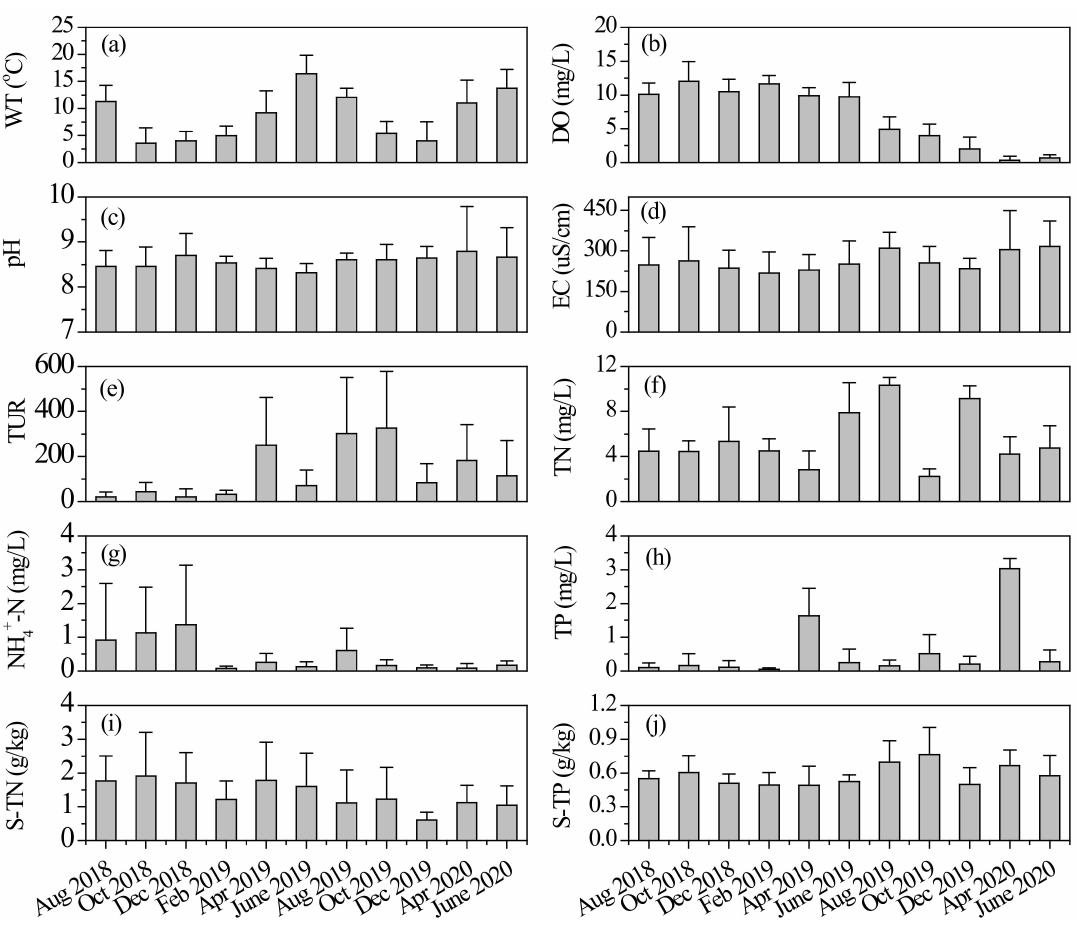
Figure 2. Average values of ( a ) water temperature, ( b ) dissolved oxygen, ( c ) pH, ( d ) electrical conductivity, ( e ) turbidity, ( f ) total nitrogen, ( g ) ammonia nitrogen, ( h ) total phosphorus, ( i ) sed- iment total nitrogen, and ( j ) sediment total phosphorus in different months, values expressed as mean ± standard deviation. S-TN: sediment total nitrogen, S-TP: sediment total